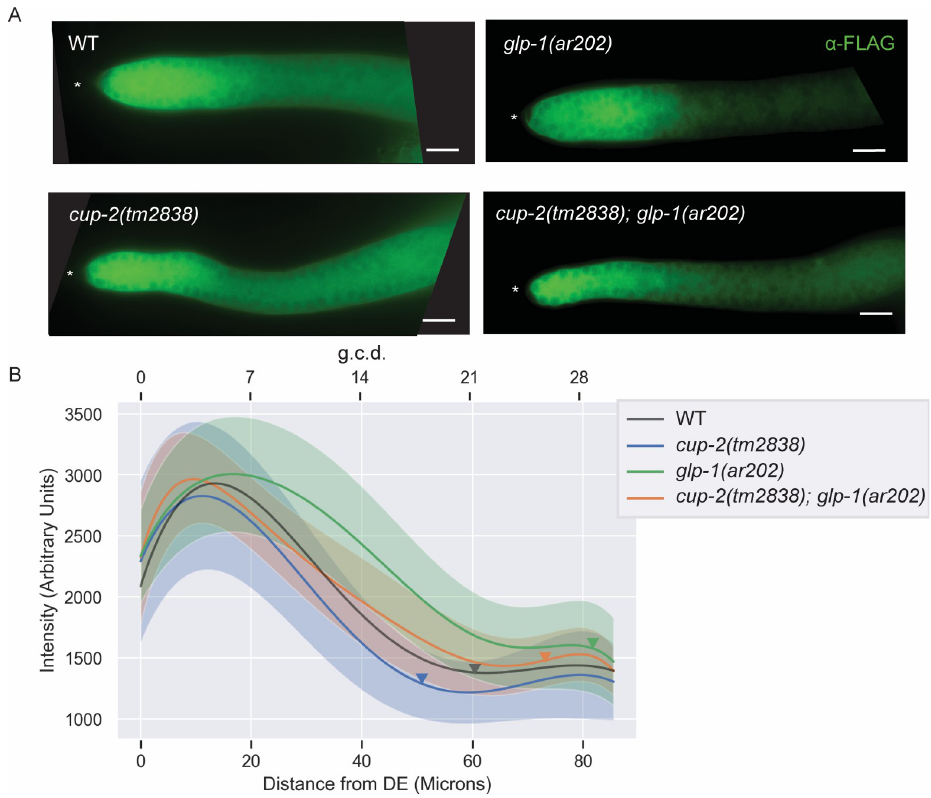
Fig 4. Loss of cup-2 decreases SYGL-1 protein levels in glp-1(ar202) germlines. A. Representative images of SYGL-1 protein expression observed in sygl-1(am307); glp-1(ar202) and cup-2(tm2838) sygl-1(am307); glp-1(ar202) genetic backgrounds by α -FLAG immunostaining. The sygl-1(am307) allele represents a 3XFLAG tagged version of endogenous SYGL-1. Asterisk, distal tip. Scale bar = 10 μ m. B. Normalized, fitted average SYGL-1 intensities measured by α -FLAG immunostaining of the indicated genotypes, each harbouring the sygl-1(am307) allele. Shaded areas indicate unscaled fitted standard deviation of the intensity measurements for each genotype. Standard deviation for average sygl-1(am307) has not been shown for ease of visualization but can be seen in S4 Fig. Average normalized intensities and standard deviations were fit to a sixth order polynomial. Fifteen gonads were analyzed for intensity measurements. Arrowheads point to the average location of the transition zone measured in at least seven gonads of each genotype. Distances from distal end (DE) were measured in microns and converted to germ cell diameters (g.c.d) as a reference, by assuming 1 g.c.d. = 2.833 microns. WT intensity measurement shown is the average sygl-1(am307) intensity across the three experiments used for